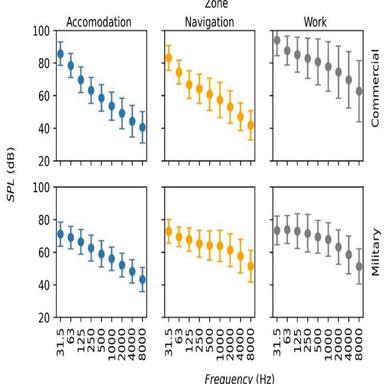
Sound Pressure Level in octave bands is classified by space and ship typology. Mean values and standard deviation (bars).